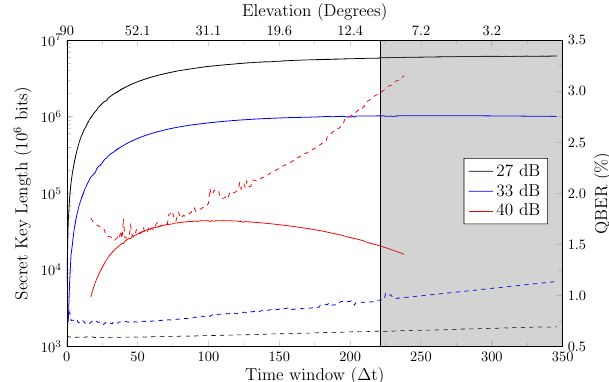
Fig. 2 Secret key length and QBER vs transmission duration. Zenith overpass with different η sys (solid lines), QBER I = 0.5%, and loss p ec = 5 × 10 − 7 . Dashed lines represent truncated block QBERs. For each Δ t , the SKL extractable from received data within − Δ t to + Δ t is values, optimised over protocol parameters. For the better η sys loss increasing Δ t beyond 200 s leads to minor SKL improvement. For larger η sys , including data from low elevations is detrimental to the loss SKL as seen by an increase in the truncated block averaged QBER. The non-smooth QBER appears since it is not the objective function of the optimisation. The shaded region indicates the time when the satellite elevation is lower than θ min ¼ 10 (cid:2)